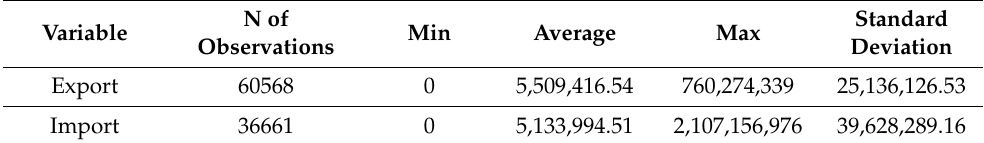
Table 1. Descriptive statistics of the dataset.